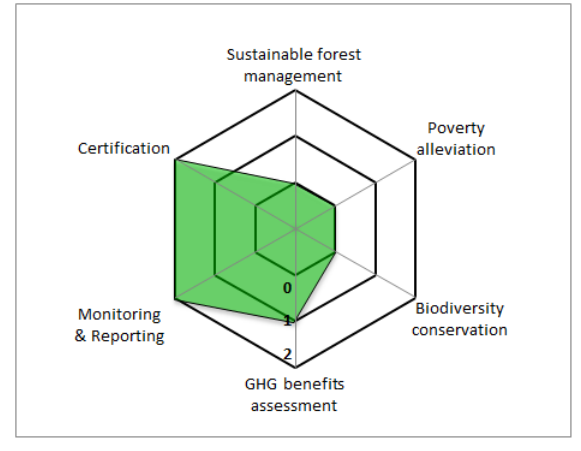
Figure 9. Summary of ISO 14064:2006: Parts 2 and 3.